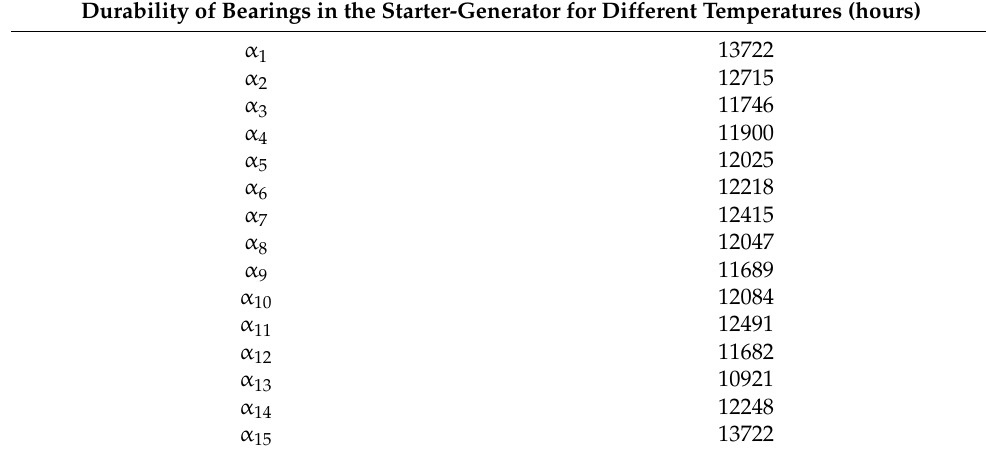
Table 1. Summary of the durability of bearings in the starter-generator.